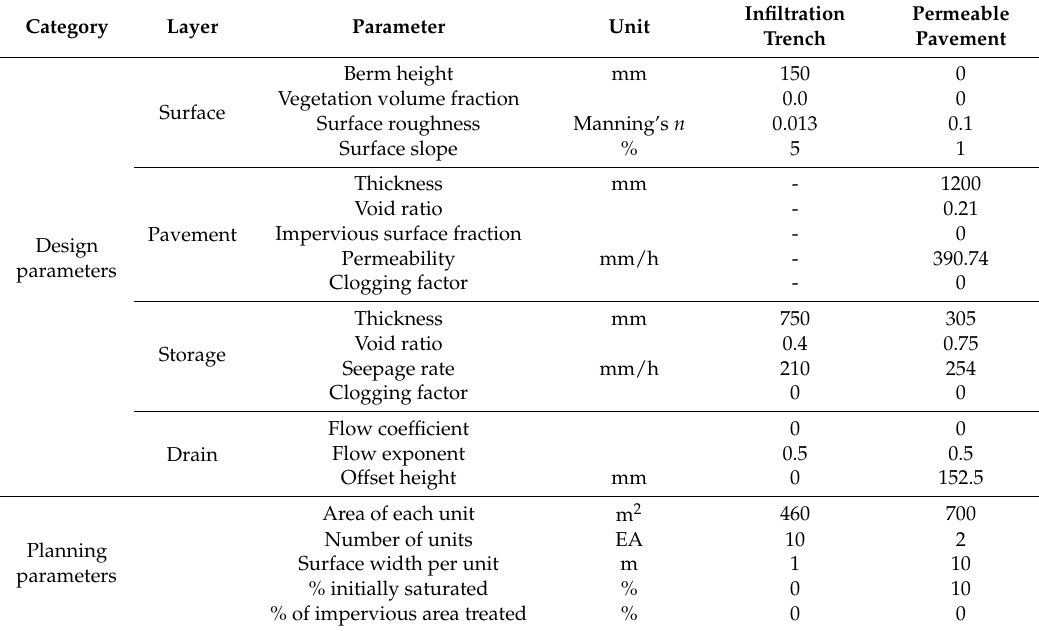
Table 3. Design and planning parameters of infiltration trench and porous pavement used in this study.